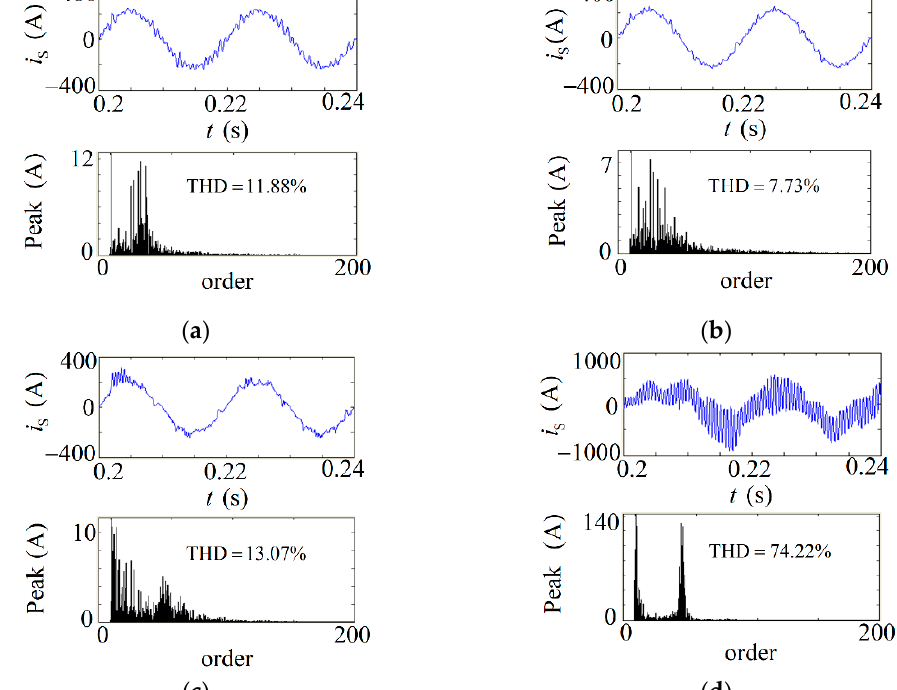
Figure 14. Grid current waveforms with different values of K ( a ) when K = 0; ( b ) when K = 0.4; ( c ) when K = 1.3; ( d ) when K = 1.6.